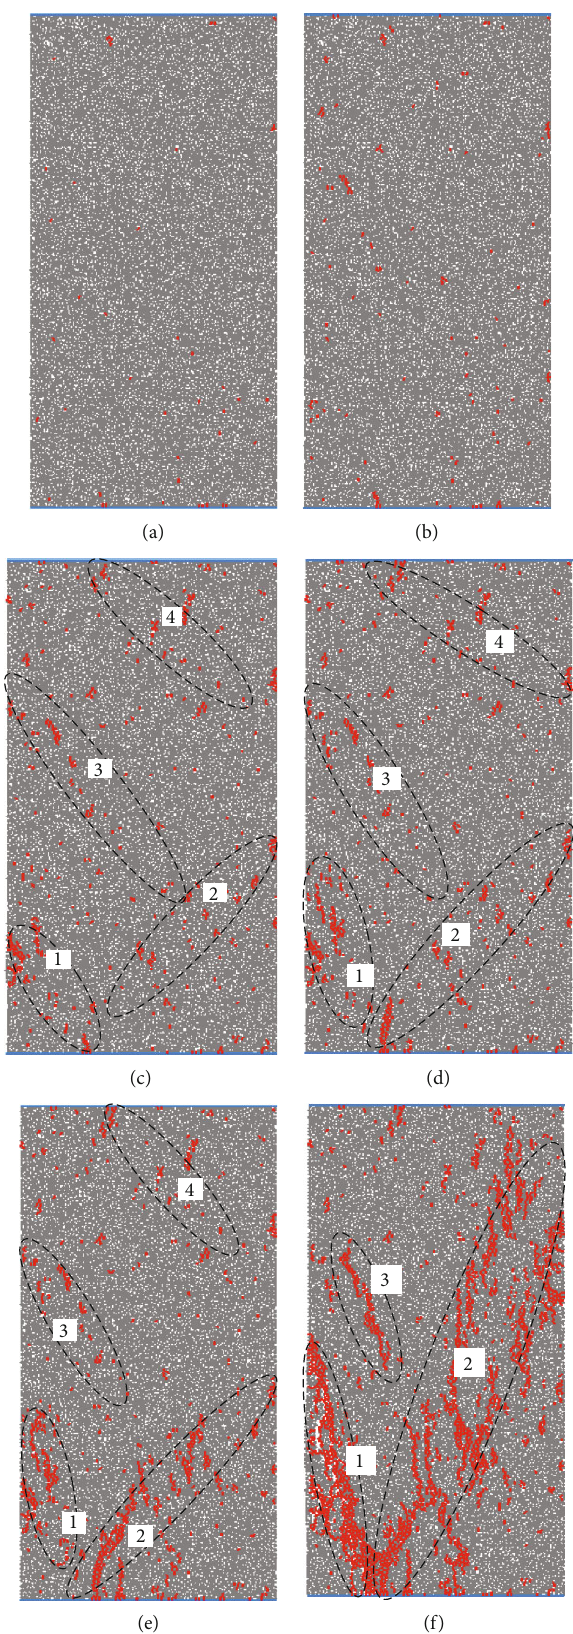
Figure 2: AE event distribution